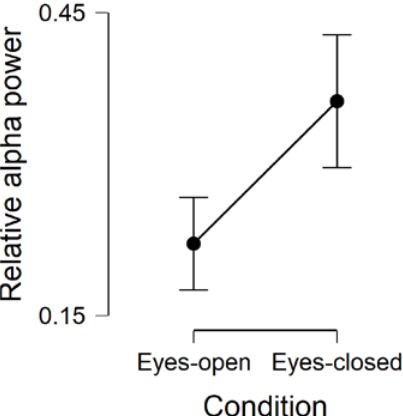
Figure 2. Comparison of absolute alpha power between children with and without autism. Error bars are 95% credible intervals.